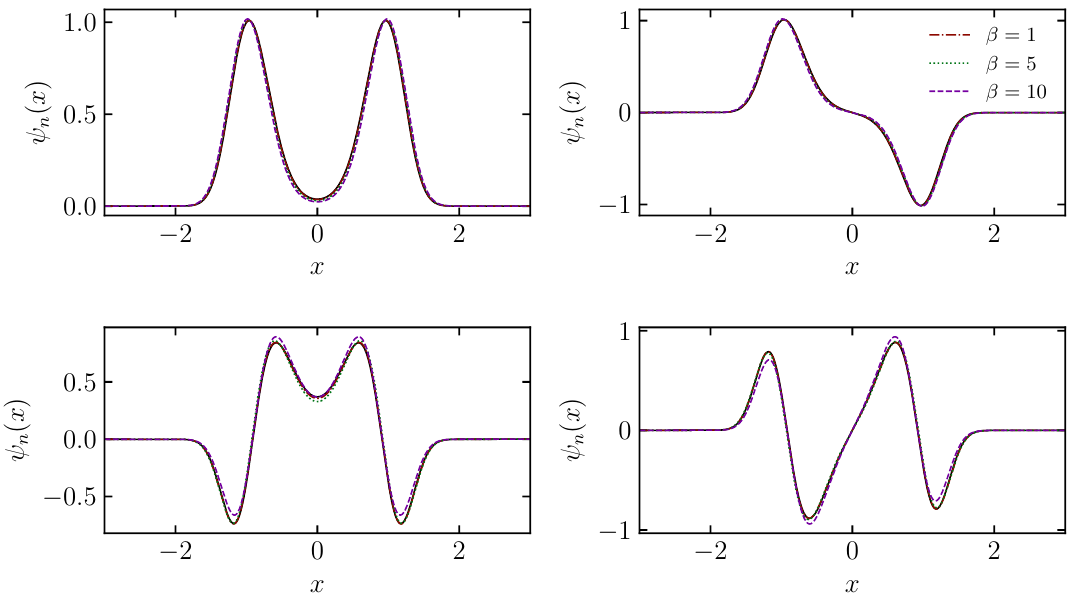
Figure 5: Comparison of the classical and quantum lowest energy tunneling states (top) and the next two tunneling states (bottom) for the double well potential V ( x ) = ν ( x 2 − 1 ) 2 / 4 . The inverse temperature is β = 1,5,10. Other parameters: m = 1, ε = ħ h = 0.1, ν =